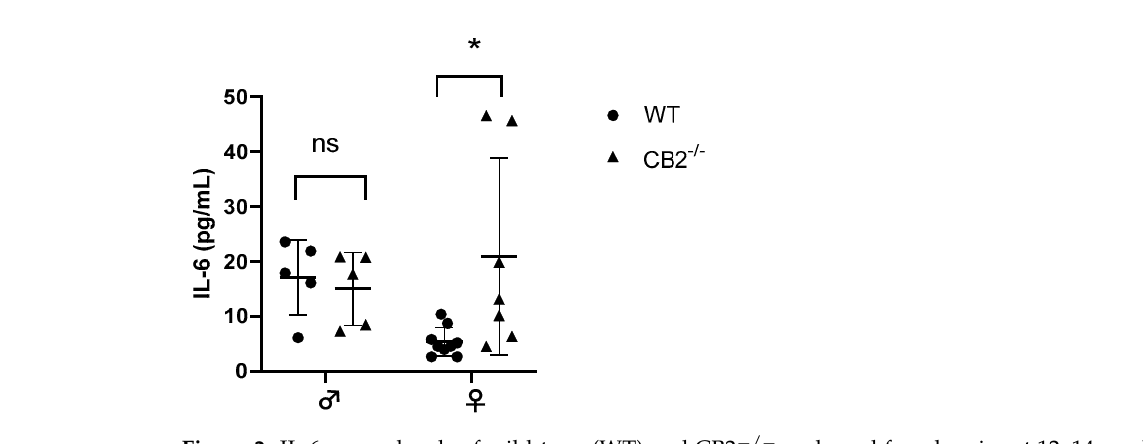
Figure 2. IL-6 serum levels of wild-type (WT) and CB2 − / − male and female mice at 12–14 weeks of age. Serum IL-6 was analyzed with the ELISA technique. n ≥ 5; Student’s t -test, * p < 0.05; ns: not significant.